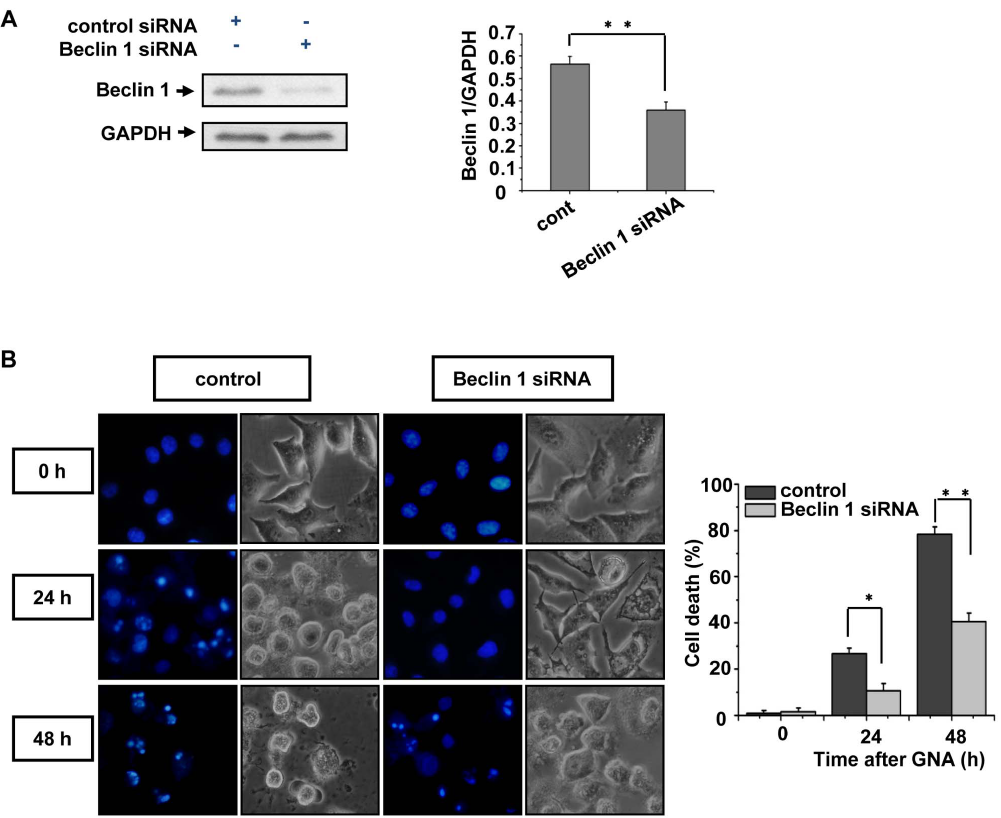
Figure 5. The knockdown of Beclin 1 decreases GNA-induced cancer cell death. A, RNA oligonucleotides against Beclin 1 (Beclin 1 siRNA) effectively repress Beclin 1 expression. A549 cells were transfected with siRNAs against Beclin 1 or negative control, and the protein level of Beclin1 was analyzed by western blotting. GAPDH protein was used as the loading control. The bar graph shows the band intensities of Beclin1 relative to those of GAPDH. Mean 6 SEM, n=3, ** p , 0.01, one-way ANOVA. B, A549 cells were transfected with siRNAs against Beclin 1 or negative control. The cells were then treated with 3 m M GNA for the indicated periods of time, stained with 2 m M Hoechst 33342 and observed under a fluorescent microscope; the percentage of dead cells was quantified by Trypan blue staining. Mean 6 SEM, n=3, *means p , 0.05, ** p , 0.01, one-way ANOVA.